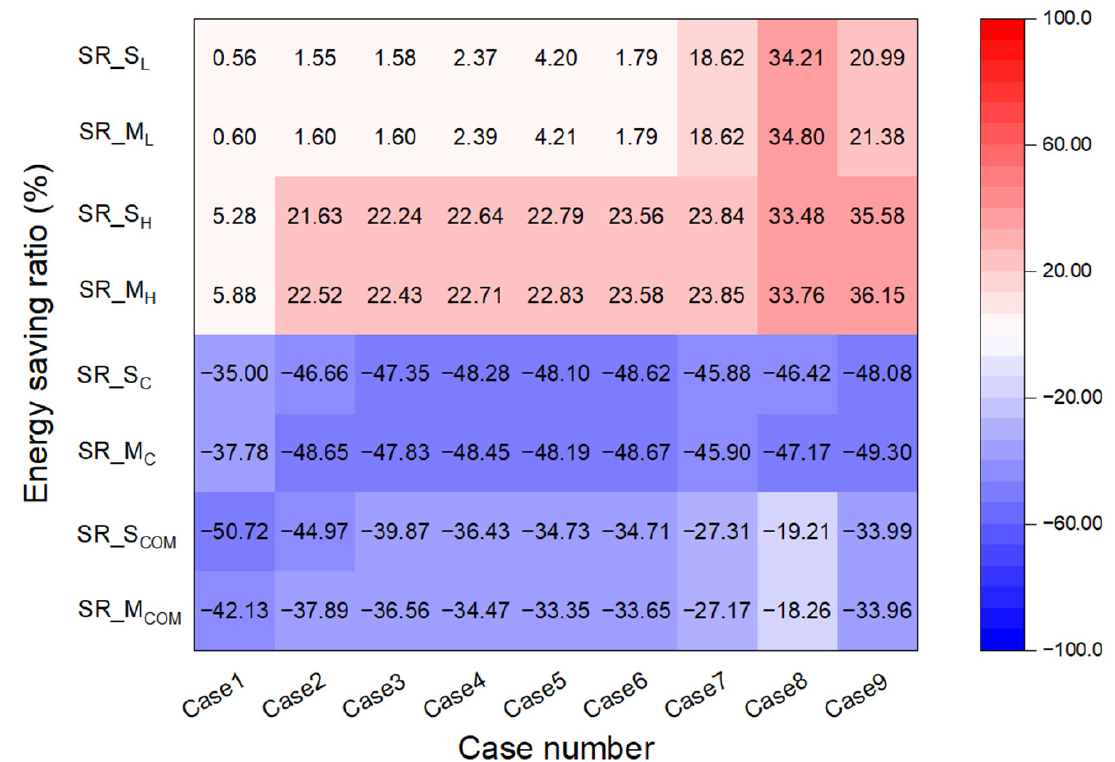
Figure 13. Energy saving analysis of buildings with different PVSDs in Harbin.